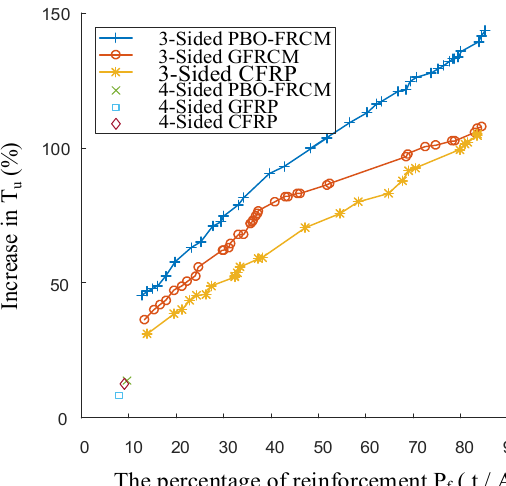
Figure 6. The effect of FRCM material on the improvement of torsional strength of repaired beams [64].